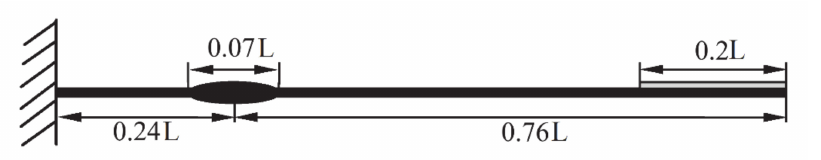
Figure 7. Optimized MFC-magnet energy harvester mechanical